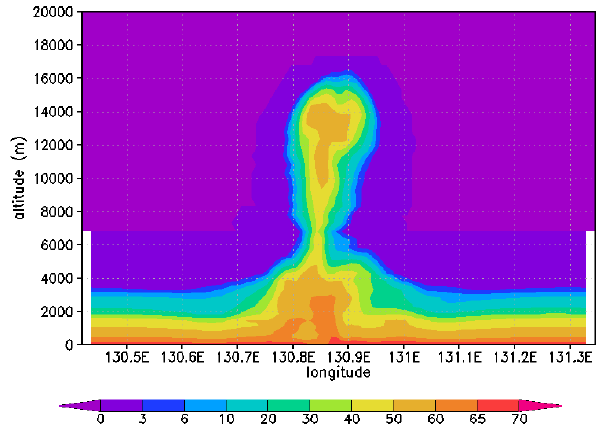
Fig. 6. Longitude altitude cross-section of the BrWMR for CHBr 3 Figure 6: Longitude altitude cross-section of the BrWMR for CHBr 3 at 12.4° S at t 0 +30min from at 12.4 ◦ S at t 0 + 30min from the PERT1 the PERT1 simulation.